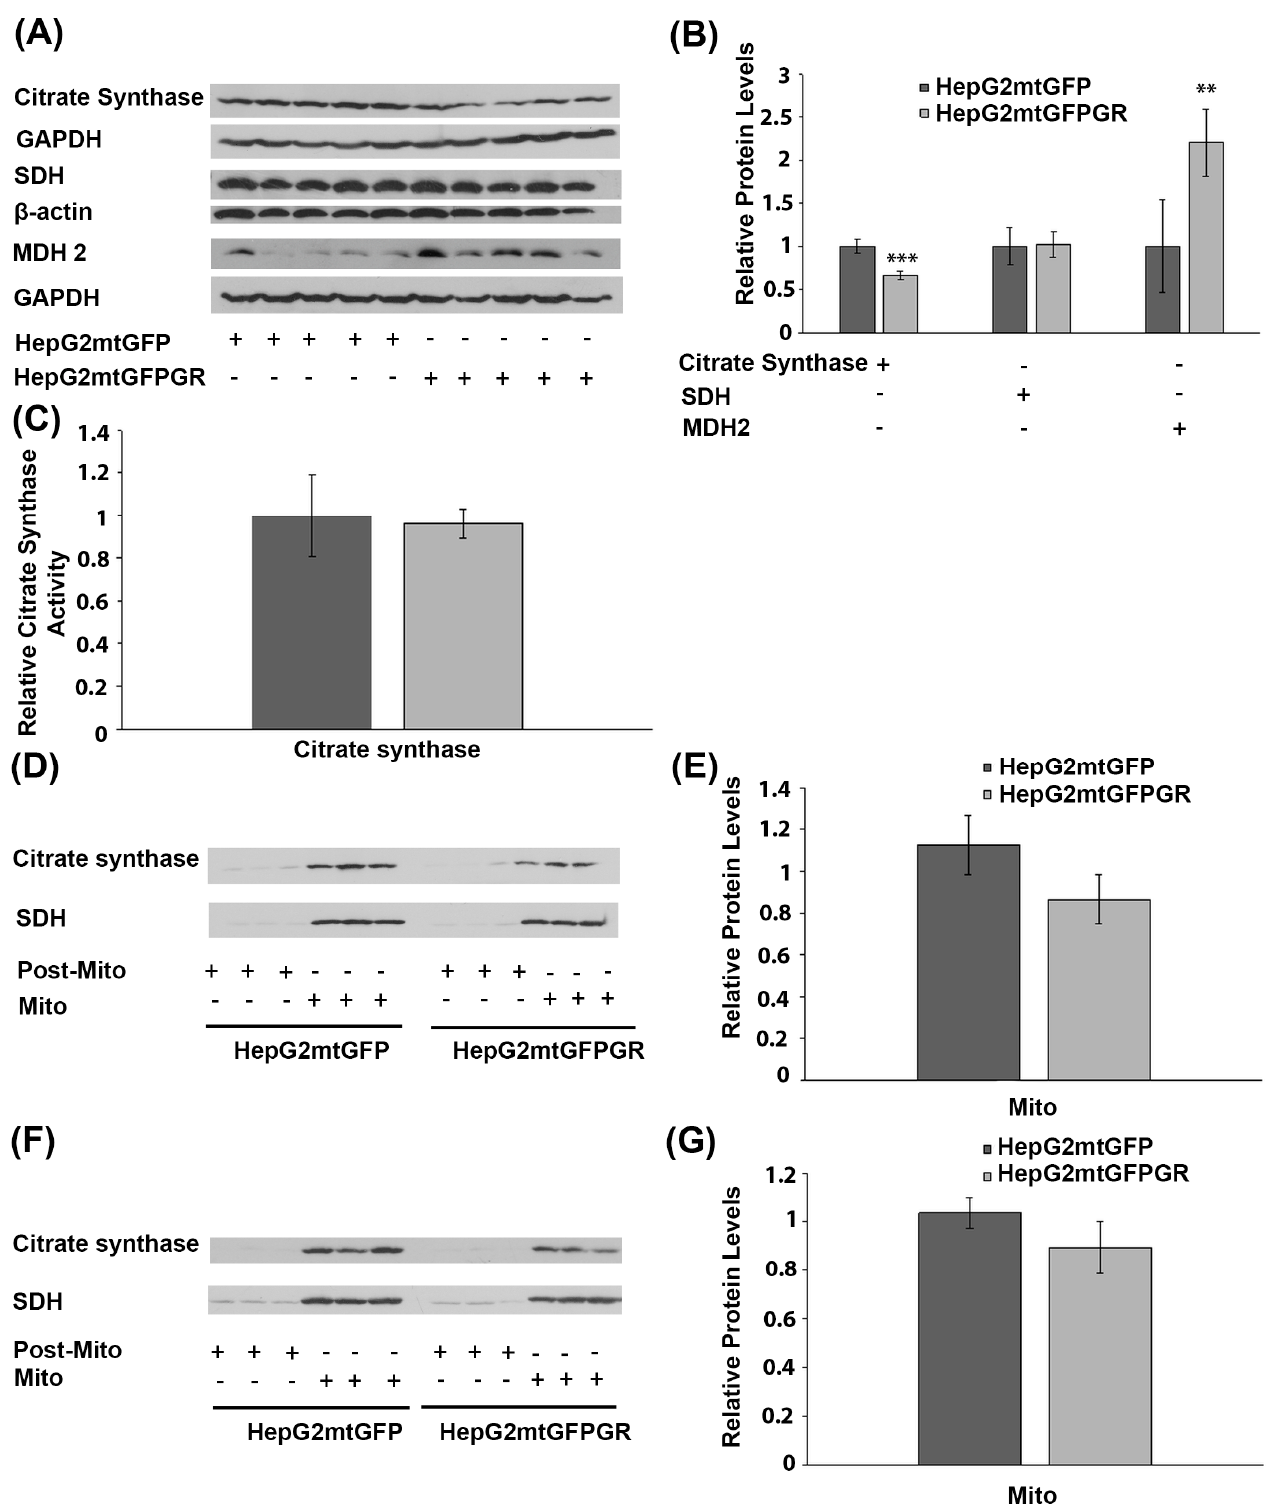
Figure 7. Effect of mtGR on Krebs cycle during in vivo tumor progression. ( A ) Western blot analysis of β -actin, GAPDH, citrate synthase, SDH, and MDH2 in extracts from tumors produced in NOD- SCID mice, inoculated with HepG2mtGFPGR and HepG2mtGFP (control) cells. ( B ) Quantification of the results. Protein levels of Krebs cycle enzymes were normalized against β -actin or GAPDH protein levels. Data are expressed as mean ± S.D ( n = 5), ** p < 0.01, *** p < 0.001. ( C ) Relative citrate synthase activity in mtGFPGR-associated tumors was expressed in comparison to the citrate syn- thase activity in mtGFP-associated tumors. Data are expressed as mean ± S.D ( n = 3). Citrate synthase